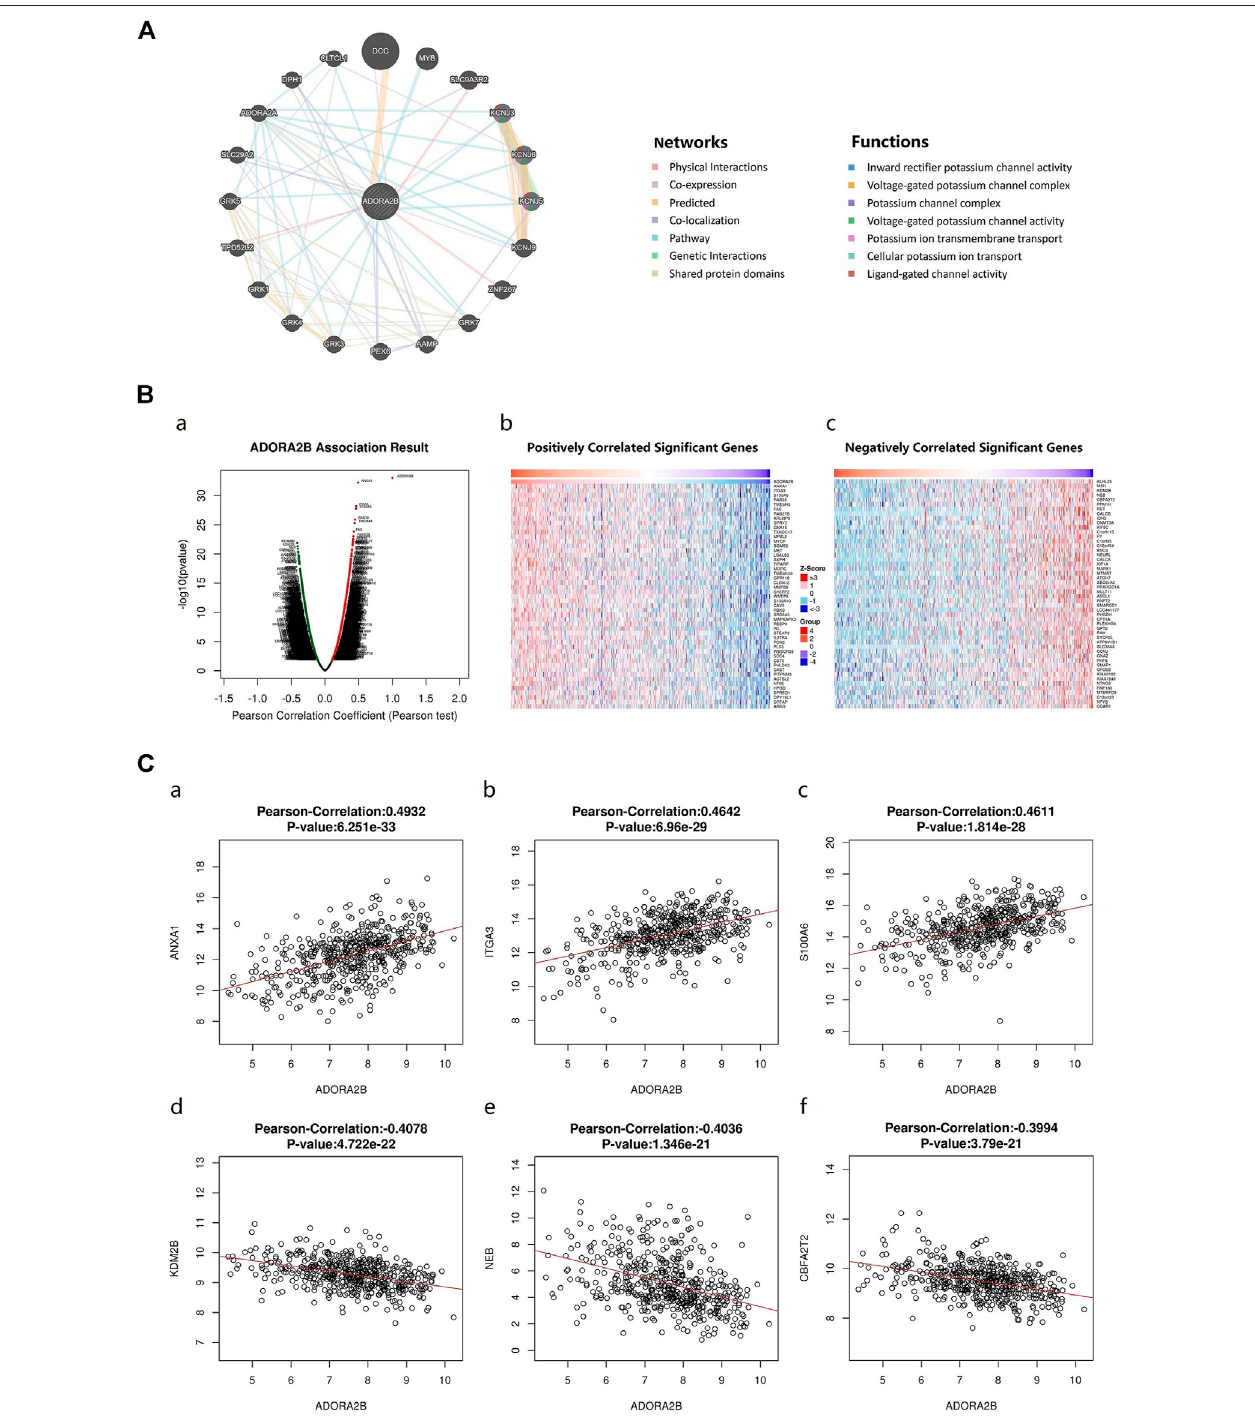
FIGURE 5 | Genes associated with ADORA2B expression. (A) Biological interaction network of ADORA2B . (B) Differentially expressed genes correlated with ADORA2B (LinkedOmics).(a) Correlations between ADORA2B anddifferentiallyexpressed genesinLUADwereanalyzedwithPearson ’ scorrelation coef fi cient.(b)Heat map of genes positively correlated with ADORA2B in LUAD. (c) Heat map of genes negatively correlated with ADORA2B in LUAD. (C) Gene expression correlation analysisof ADORA2B and ADORA2B -correlatedgenes(LinkedOmics).Pearsoncorrelationof ADORA2B expressionwiththatof(a) ANXA1 ,(b) ITGA3 ,(c) S100A6 , (d) KDM2B , (e) NEB , and (f) CBFA2T2 ( n (cid:1) 515).